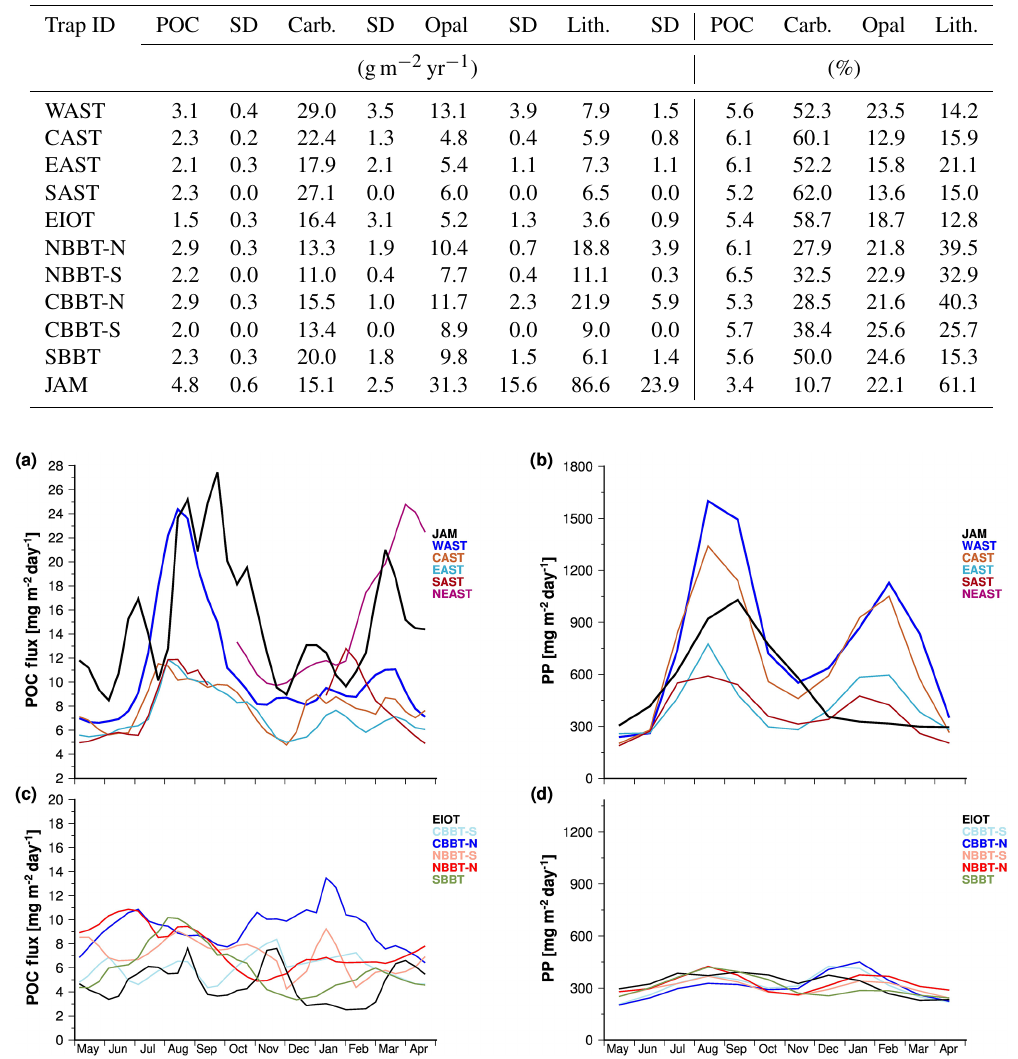
Table 4. Trap ID, mean bulk fluxes including standard deviation (SD) and contents. In contrast to averages presented in Table 3, all data, including those measured in years in which fluxes were measured for fewer than 255 days, were used to calculate mean values and the standard deviations shown in this table.